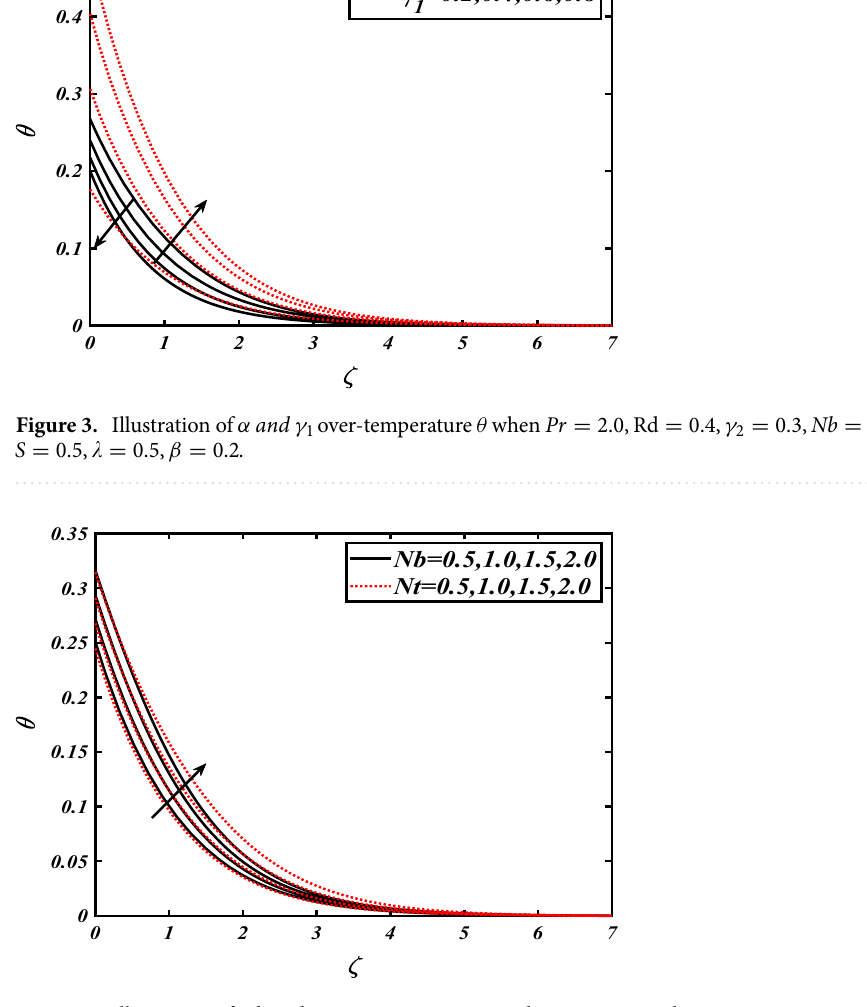
Figure 4. Illustration of Nb and Nt over-temperature θ when Pr = 2.0, Rd = 0.4, γ 2 = 0.3, Nr = 0.2, Nc = 0.2, S = 0.5, (cid:31) = 0.5, β = 0.2 .